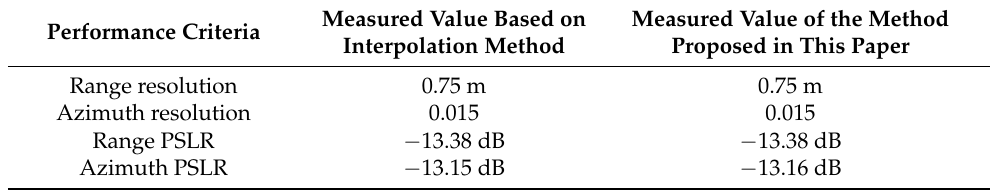
Figure 15. Point target profile. ( a ) Range profile. ( b ) Azimuthal profile. Table 3. Point target performance